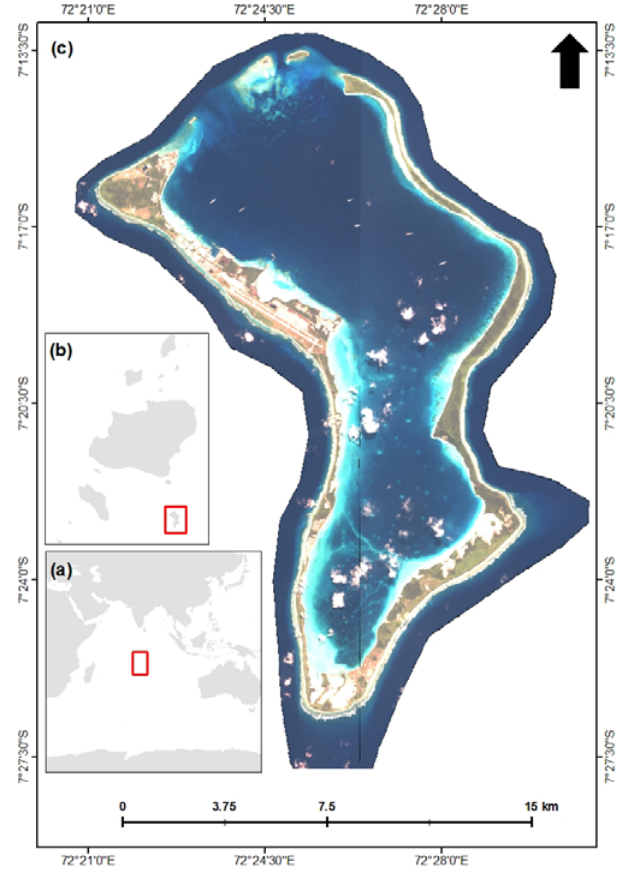
Figure 1. The study site ( a ) the location of the British Indian Ocean Territory in the central Indian Ocean, ( b ) the location of Diego Garcia at the southern end of the Chagos archipelago (BIOT), and ( c ) Diego Garcia